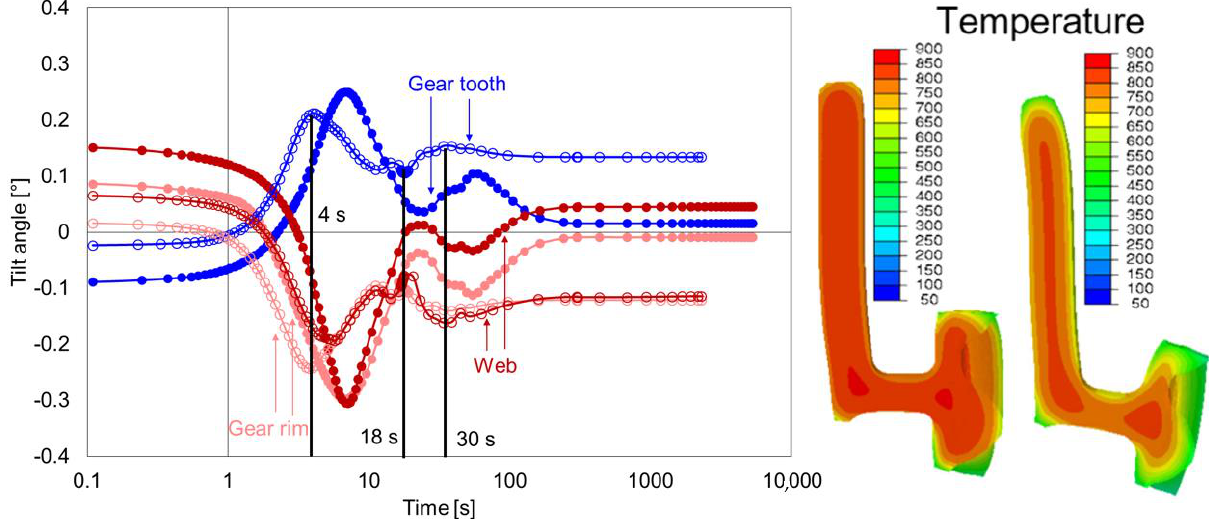
Figure 16. Tilt angle development of the web, gear rim, and gear tooth for the geometry type G2 (circle without fill) and comparison with geometry type G1 (circle with fill) during quenching ( left ), and temperature distribution and contour plots for G2 after 2 s and 4 s ( right ).